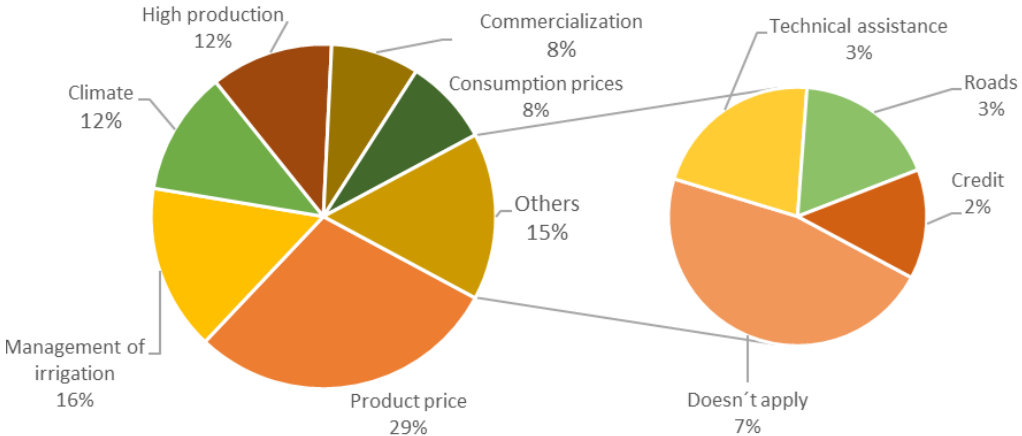
Figure 4. Factors determining the success of productivity based on the census of users of the irrigation districts.